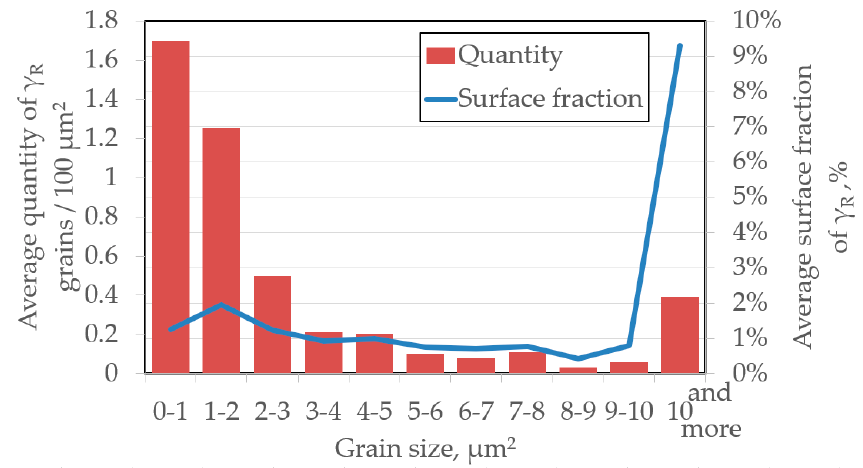
Figure 6. Statistical evaluation of average grains quantity per 100 µ m 2 and the average surface fraction of different size for γ R grains.